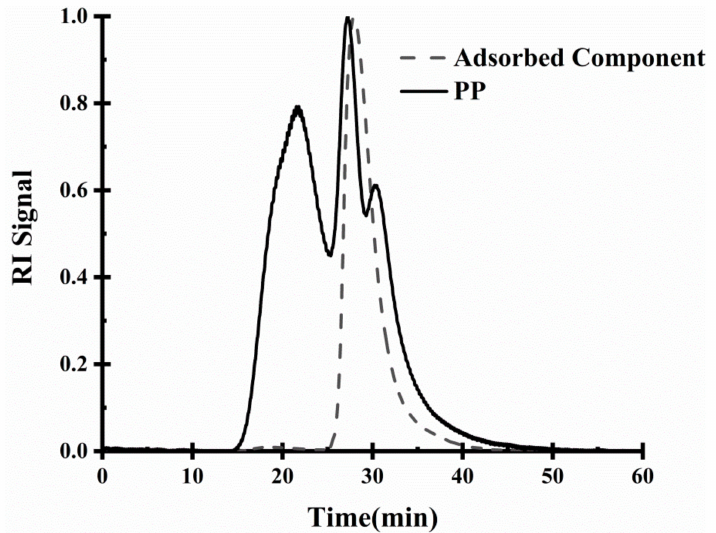
Figure 7. Gel permeation chromatography (GPC) elution profile of initial PP and PP component adsorbed at the emulsion interface (parallax